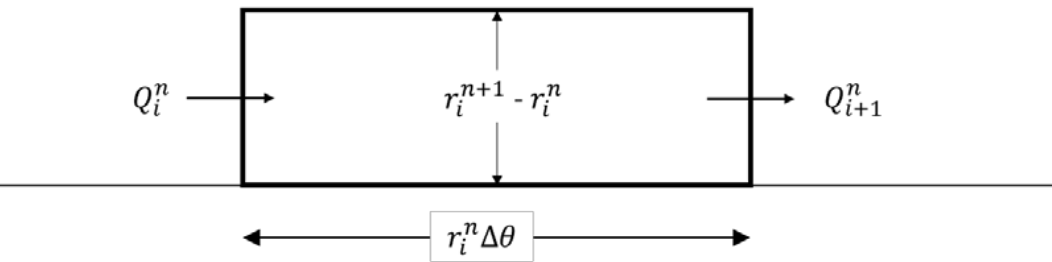
Figure 3. The rectangular control volume defined in this study and its dimension.